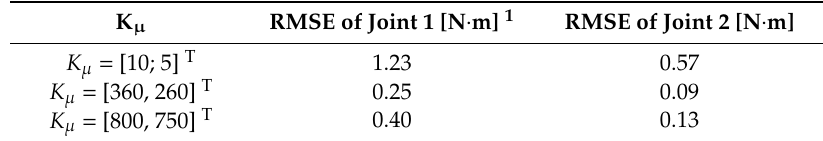
Figure 4. Comparison of the position and velocity tracking performance of joint 1 with and without friction compensation in the controller. ( a ) Position tracking error without friction compensation (NC) and with friction compensation (WC). ( b ) Velocity tracking error without friction compensation (NC) and with friction compensation (WC). Table 1. The estimated friction torque errors for di ff erent gain coe ffi cients ( K µ Table 2. Position and velocity tracking errors for joint 1.